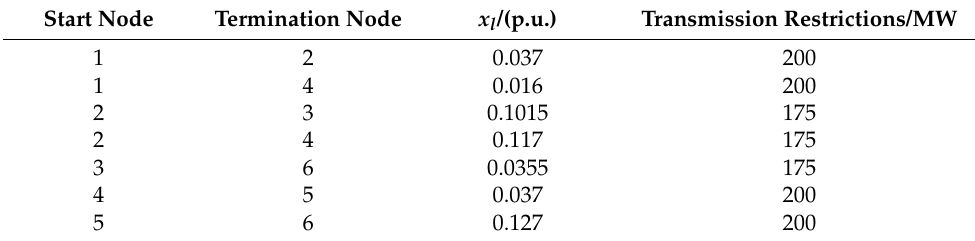
Table A3. Parameters of transmission lines.